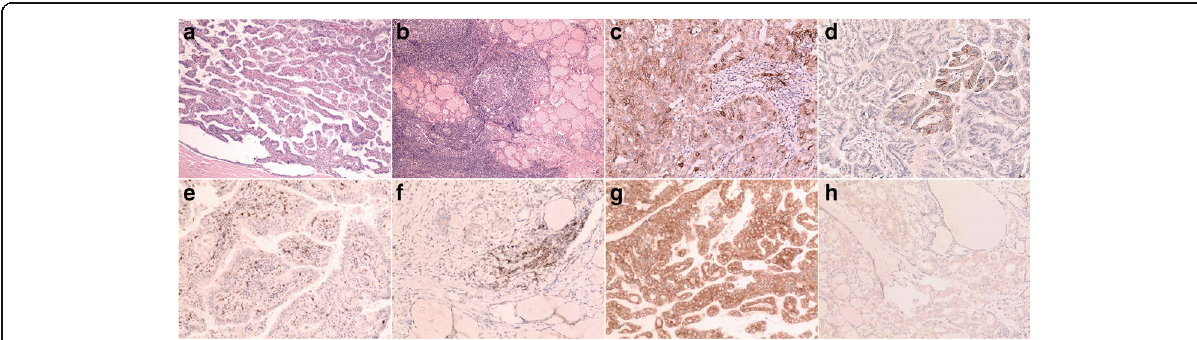
Fig. 1 a , Papillary thyroid carcinoma (PTC) with predominant papillary structures; b , The background thyroid tissue of ( a ), which showed dense lymphoplasmacytic infiltrates and germinal center formation indicating the presence of chronic lymphocytic thyroiditis; c , PD-L1 was diffusely expressed both on the cell membrane and the cytoplasm. Please note there was also staining on the tumor-infiltrating lymphocytes (TILs), which should not be regarded as positive staining of the tumor cells; d , PD-L1 was focally expressed on the tumor cell membrane; e , PD-1 expression of the TILs was identified in the tumor stroma; f , PD-1 expression was noted in the tumor invasive front; g , BRAF V600E was strongly and diffusely expressed on the tumor cytoplasm; h , Mild but diffuse expression of BRAF V600E was noted on the